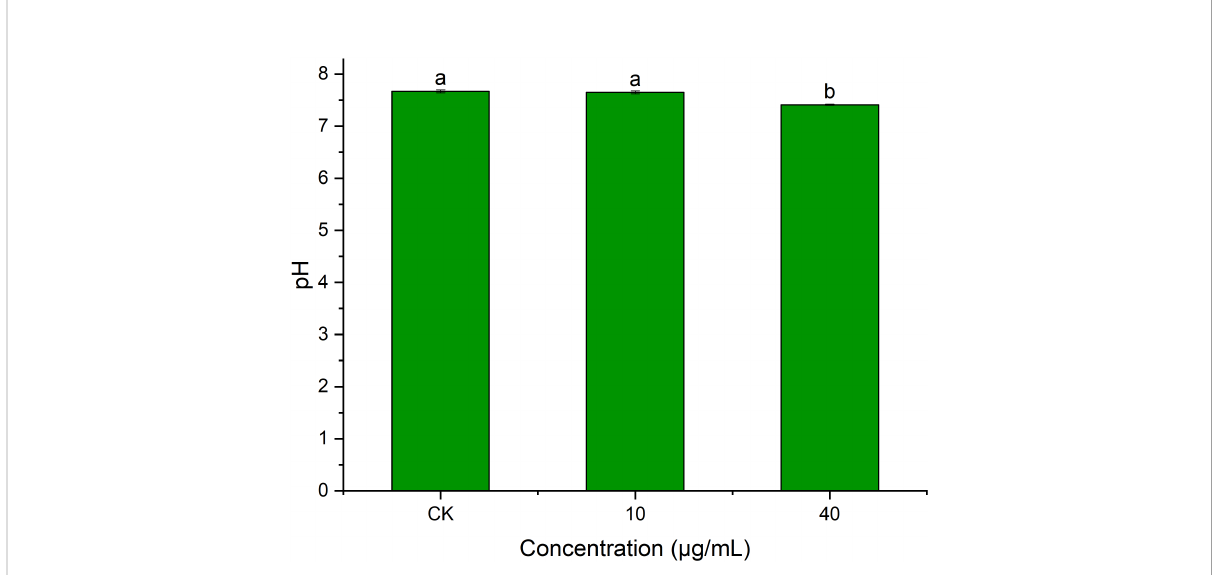
FIGURE 9 Effect of the antifungal compound PCN on the extracellular pH of R. solani AG1IA. Different lowercase letters indicate signi fi cant differences ( P<0.05